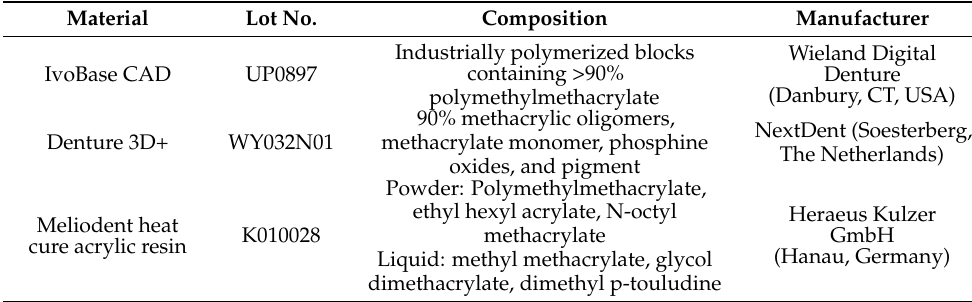
Figure 1. Representative disc image fabricated using three different techniques ( A ), The standard tessellation language (.STL) file of the digital disc used for fabrication of milled and 3D print discs ( B ). Table 1. Materials used in the